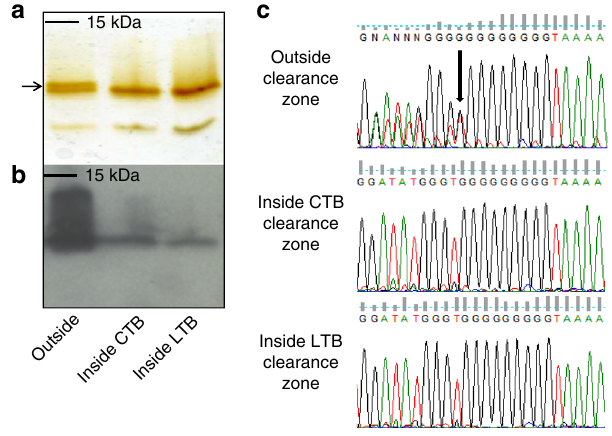
Fig. 4 Exposure of C. jejuni 11168 cells to cholera toxin B subunit (CTB) led to changes in lipooligosaccharide (LOS) structure. This is shown by silver stain ( a ) and far western blot using CTB as a probe ( b ). CTB exposure also led to changes in the length of the poly-G tract in the cgtB gene, which is essential for GM1 ganglioside mimicry, leading to a frameshift mutation ( c ). The arrow in a marks the two bands associated with two distinct LOS structures in wildtype 11168 and the arrow in c marks the ninth G in the homopolymeric tract where heterogeneity is seen in the sequence. Source data are provided as a Source Data fi